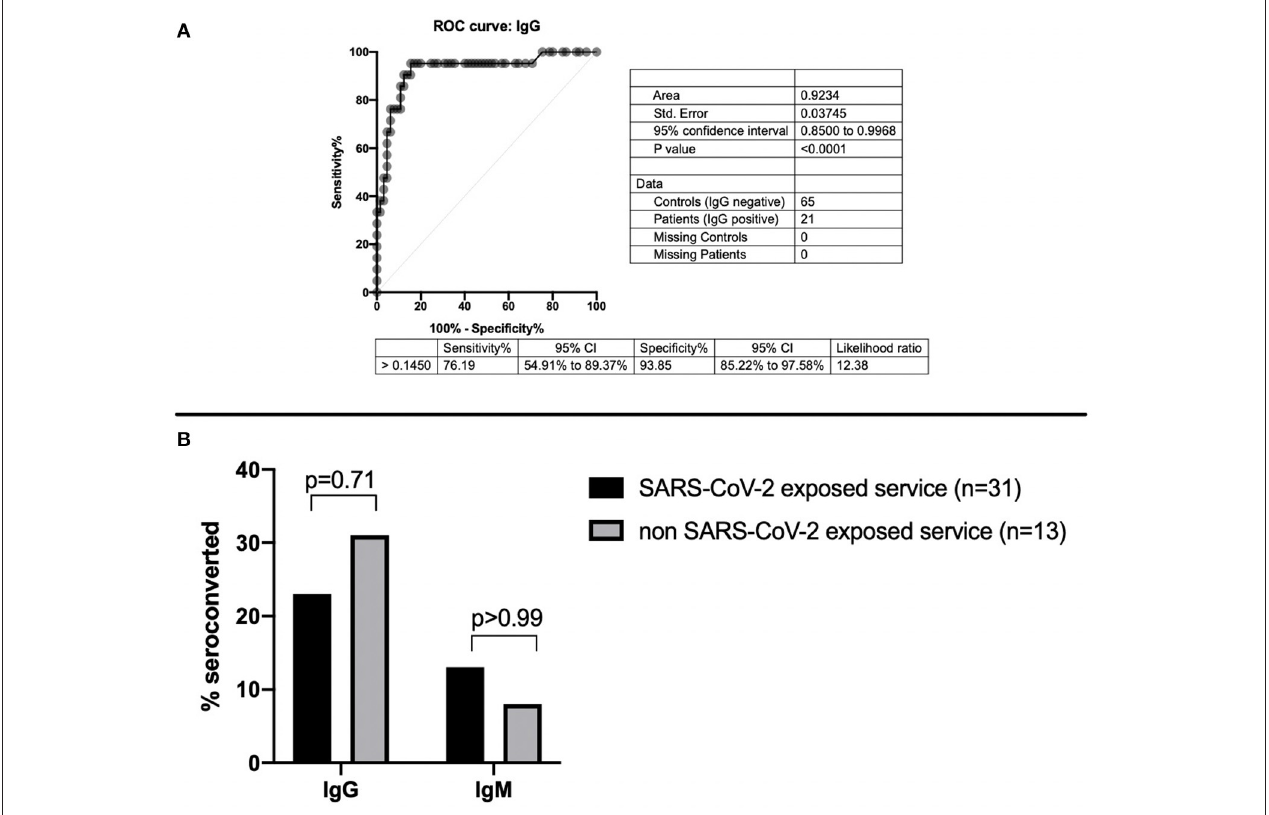
FIGURE 1 | (A) Sensitivity and specificity of SARS-CoV-2 IgG ELISA. (B) SARS-CoV-2 IgG and IgM seroconversion based on exposure to COVID-19 patients.